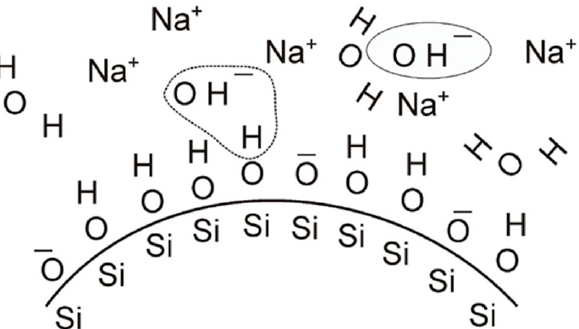
Figure 5. Schematic of the charge formation on the surface of SiO 2 particle in colloidal silica-based binder stabilized by sodium hydroxide, adapted from [53].